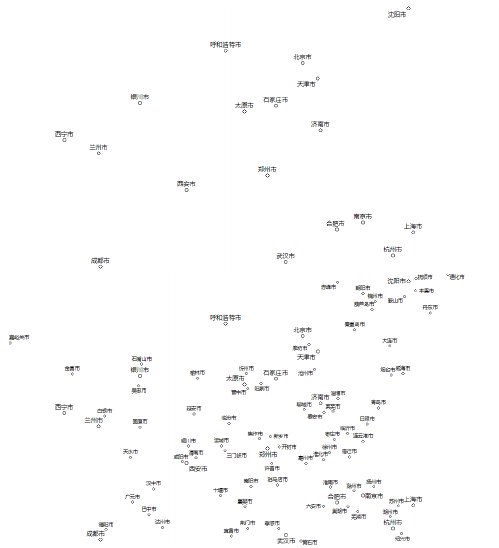
Fig6 place names display under the general rule(top) and u place name display under the gravitational field rule